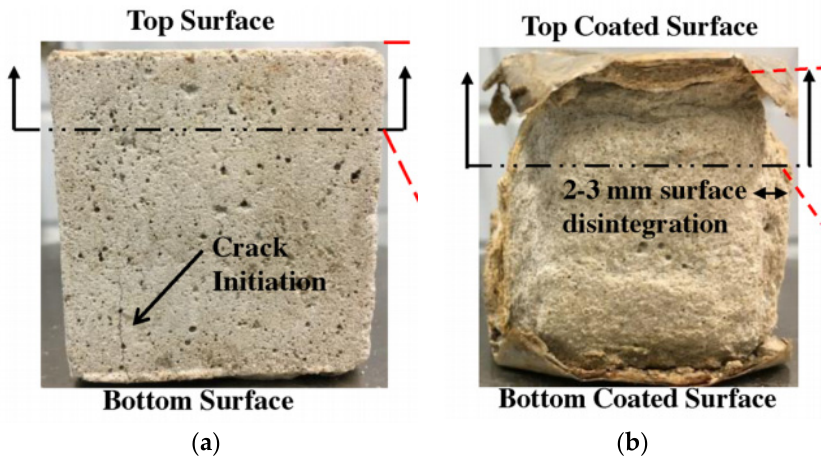
Figure 8. Visual assessment of geopolymer mortar after two years of exposure [64]. ( a ) FA-GPm; ( b ) SRPC.